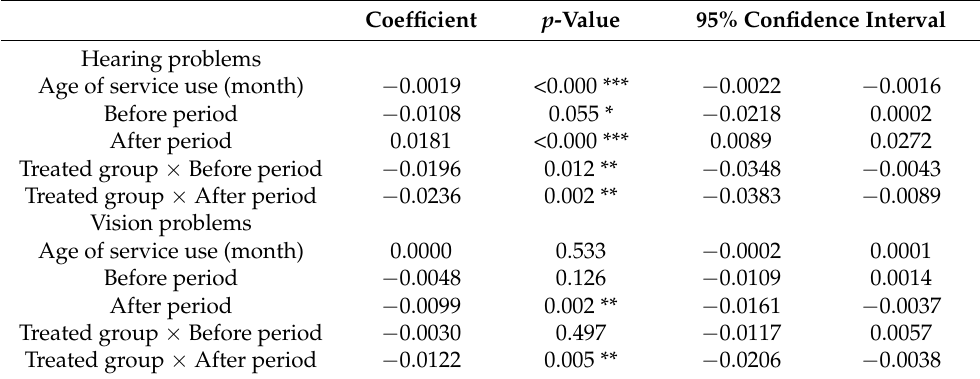
Table A3. Predicted coefficient of the interaction term of treated groups and period: Hearing and